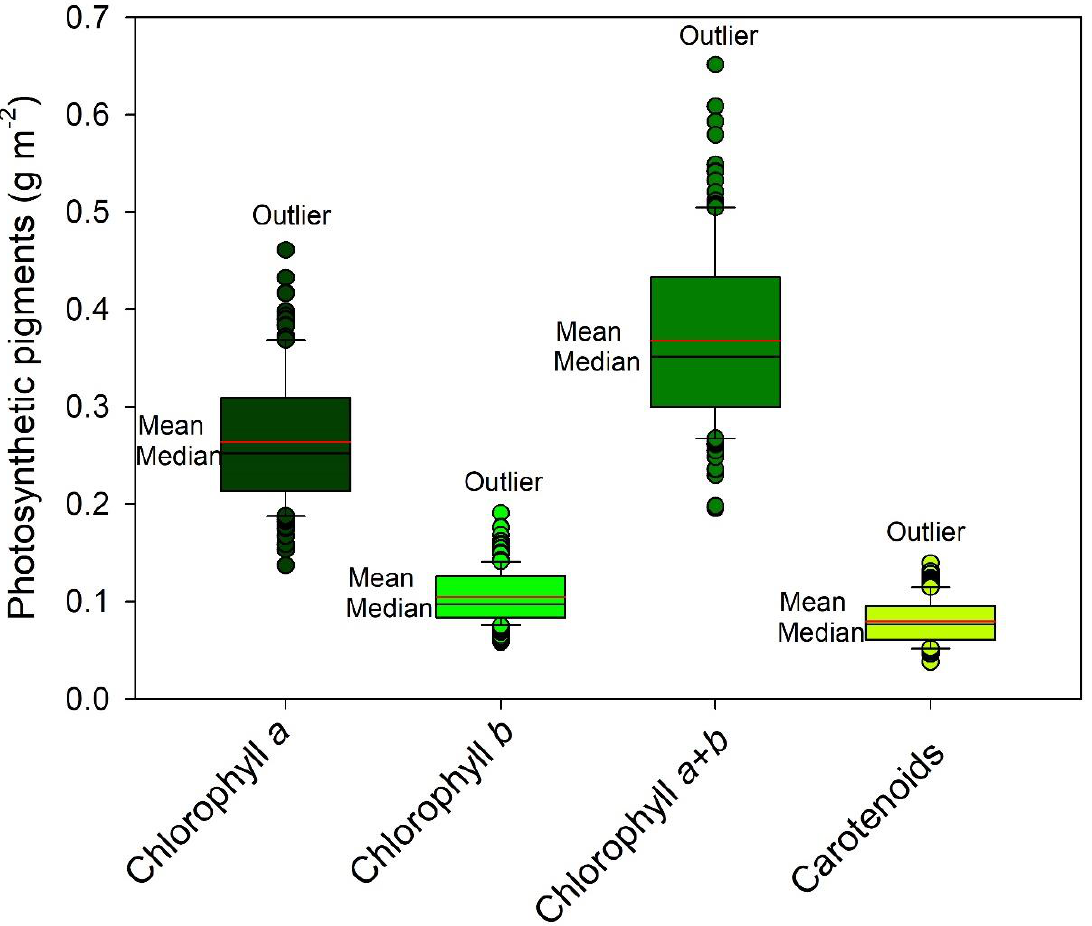
Figure 8. Box plot of descriptive statistics of photosynthetic pigments (chlorophylls a , b , total ( a + b ) and carotenoids) quantified from the leaves of Nicotiana tabacum in which the reflectance (R), transmittance (T), and absorbance (A) spectra were measured. ( n = 150).